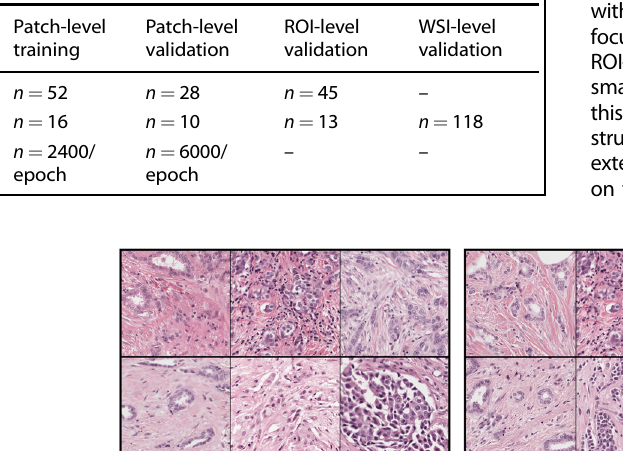
Table 2. Overview of the number of patches, regions of interests (ROIs) and whole-slide images (WSIs) used for training and validation purposes in this